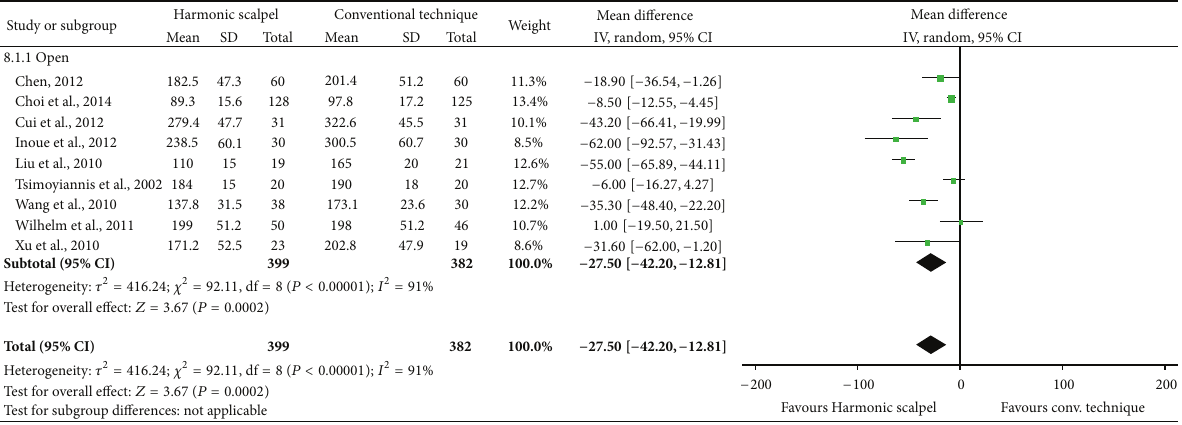
Figure 3: Forest plot of meta-analysis results for operating time (minutes), stratified by open versus laparoscopic surgery. Harmonic scalpel Study or subgroup